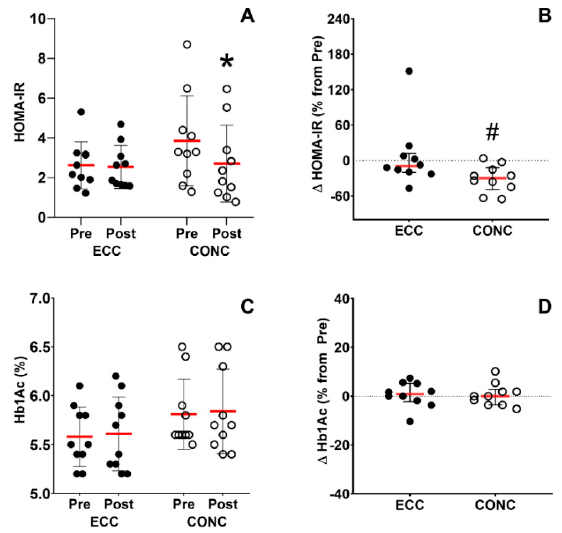
Figure 5. Insulin sensitivity. Homeostatic model assessment insulin resistance (HOMA-IR) in absolute values ( A ) and as a percentage of change from pre-training values ( B ). Whole-blood glycosylated hemoglobin (%Hb1ac) in absolute values ( C ) and as a percentage of change from pre-training values ( D ). ECC: eccentric cycling, CONC: concentric cycling. *: p < 0.05 Pre vs. Post, #: p < 0.05 ECC vs. CONC.